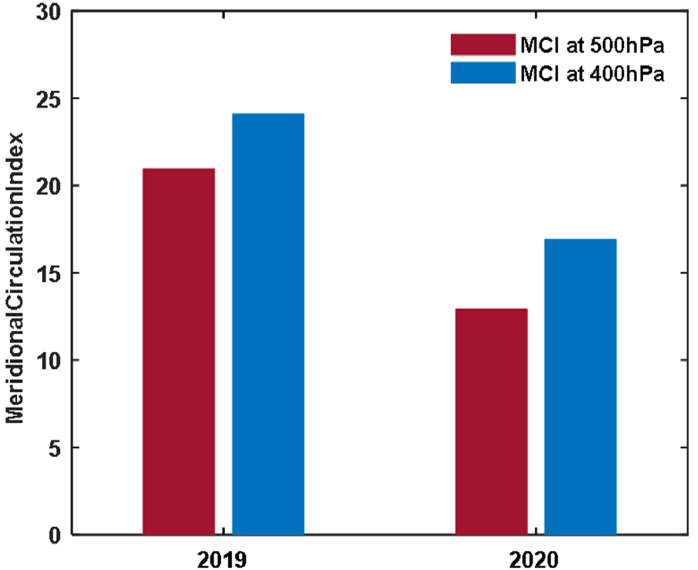
Figure 7. The meridional circulation index at 500 and 400 hPa in FMC_2019 and FMC_2020. According to existing research, PBLH, temperature inversion, RH, and WS are the meteorological factors closely related to PM 2.5 [28,93], among which the difference of temperature between 900 and 1000 hPa (T 900 − T 1000 ) refers to the temperature inversion and atmospheric stability [55,93]. Figure 8 and Table 5 show the fractional changes of the PBLH, T 900 − T 1000 , RH at 1000 hPa (RH 1000 ), and WS at 1000 hPa (WS 1000 ) between FMC_2020 and FMC_2019. It can be seen that in the BTH in FMC_2020, the PBLH has decreased by 24% and the lower PBLH allows PM 2.5 to mix in a smaller range; the